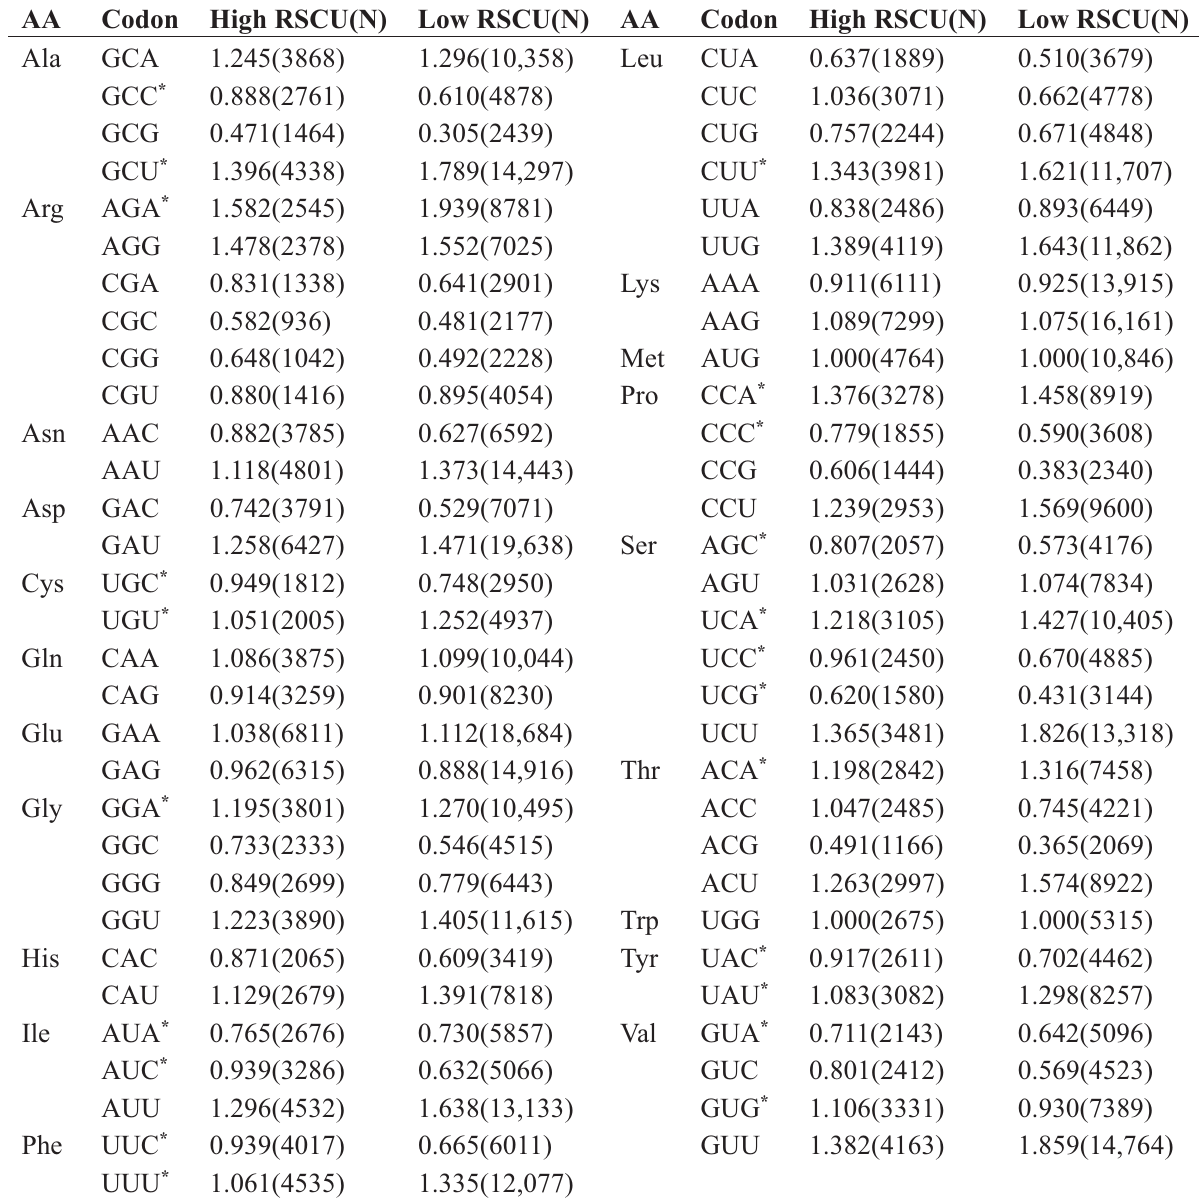
Table 2. Comparison of codon usage frequencies between P . lactiflora sequences with high and low levels of